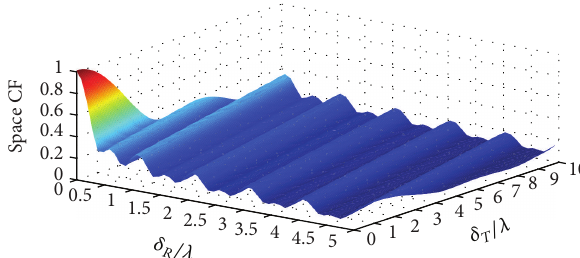
Figure 10: The space CF in the obstructed segment.